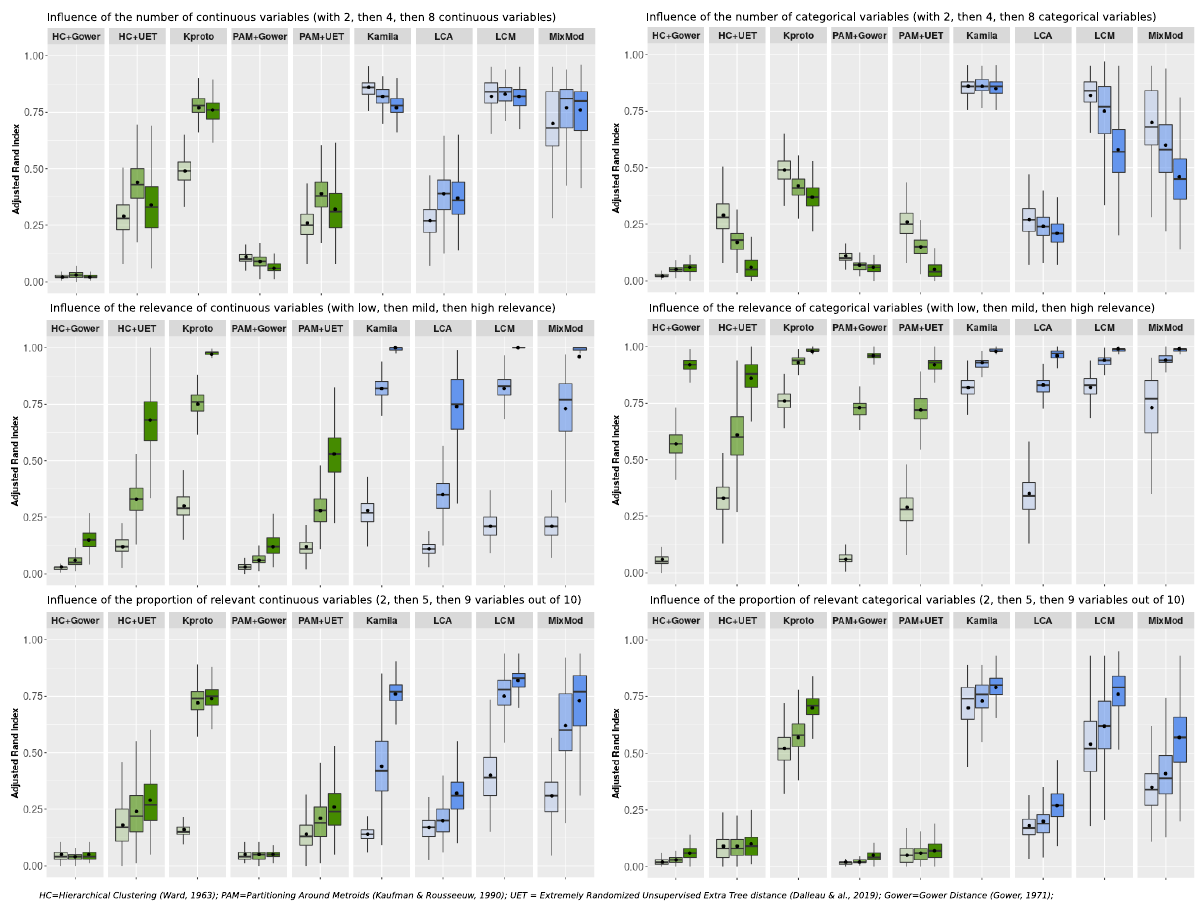
Figure 2. Influence of characteristics of continuous and categorical variables on clustering performance in simulation studies. Top panels: scenario 3 applied to continuous (left) and categorical (right) variables; middle panels: scenarios 4 (left) and 5 (right) ; bottom panels : scenarios 6 (left) and 7 (right)—as defined in Table 2. This figure title was generated using R (R: A Language and Environment for Statistical Computing, R